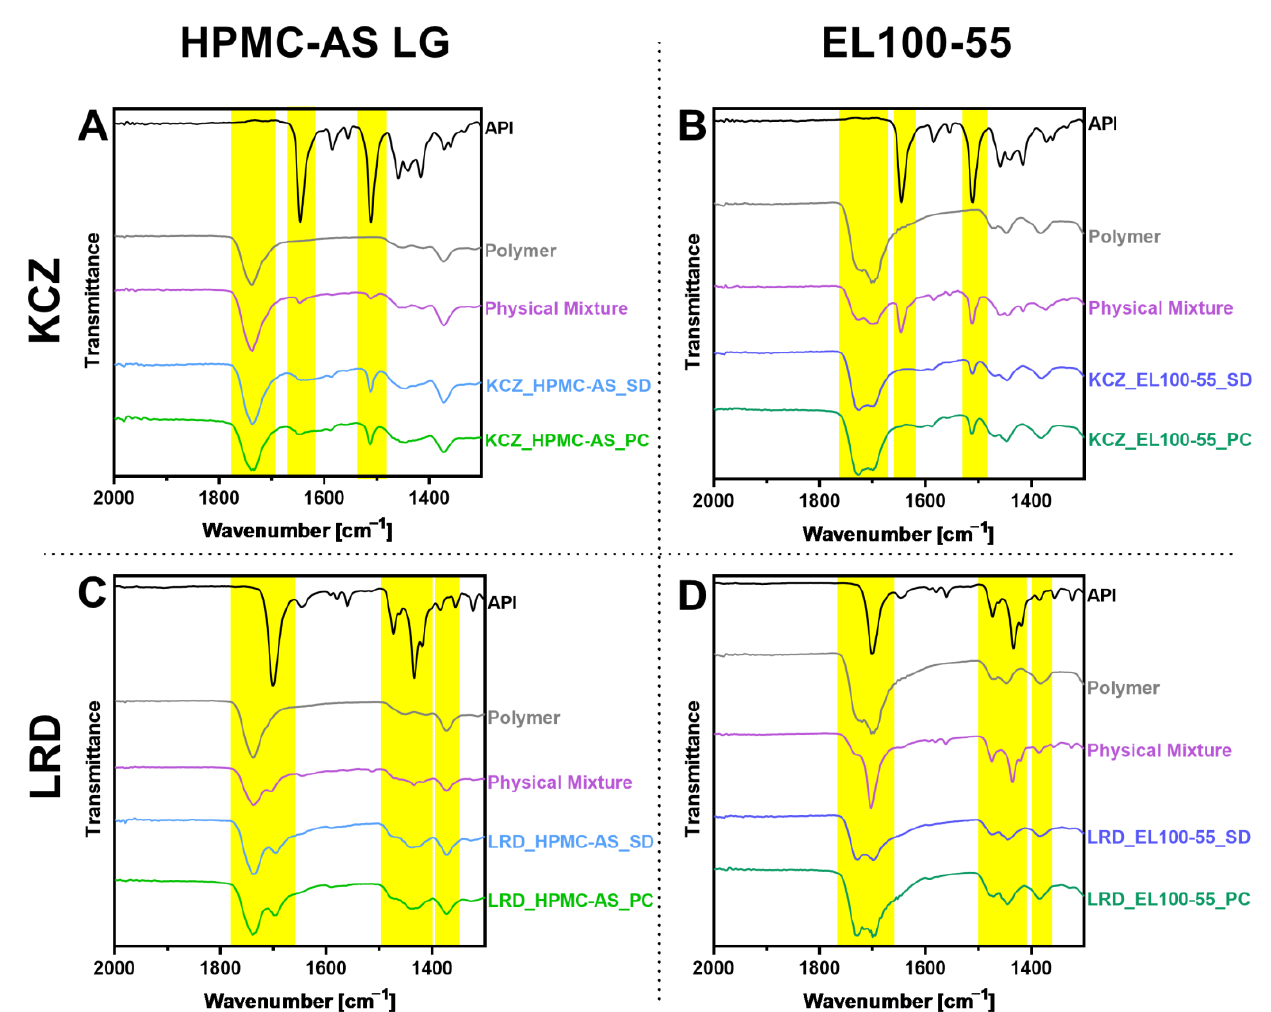
Figure 5. FT-IR-measurements of all prepared samples, pure APIs, pure polymers and their respective physical mixtures containing ( A ) KCZ and HPMC-AS L; ( B ) KCZ and EL100-55; ( C ) LRD and HPMC-AS; and ( D ) LRD and EL100-55. Yellow bars representing region of interest. Measurements were performed with a FT-IR Spectrum two LiTa (Perkin Elmar). 1300 – 2000 cm −1 .